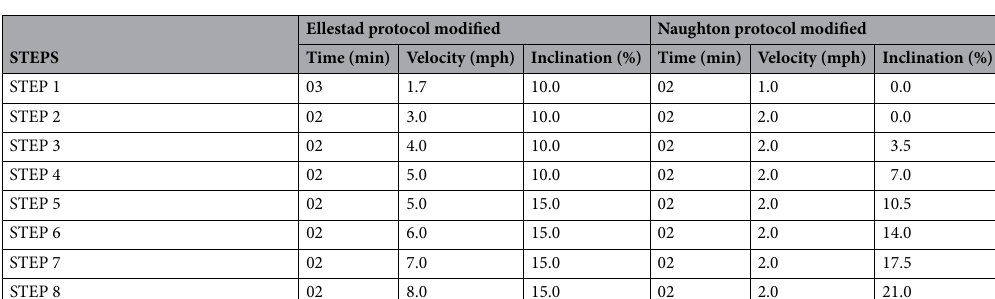
Figure 2. ( A ) Separation of beats into 2 categories A or B, even and odd, etc., successively during the performance of TWA by MMA method. ( B ) The model is updated by a small part of the difference between the old model and the new raw data (update factor or sensitivity, which can represent 1/8, 1/16, 1/32 or 1/64 of the difference between the mean and the new beat in question, and this value will be added to the average— “update”). Adapted from Verrier et al. 10,29